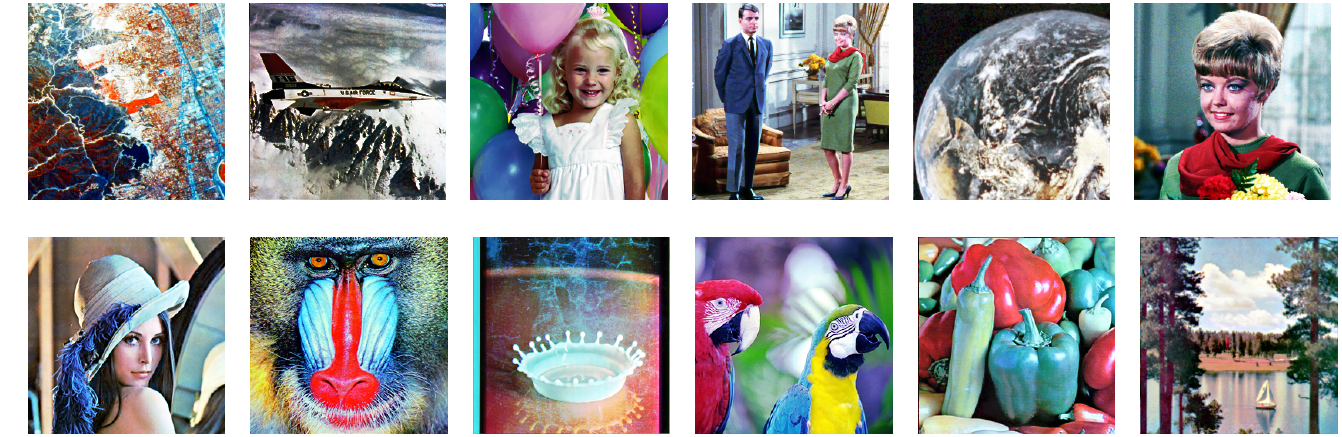
Figure 21. Results of separable histogram equalization with Nikolova and Steidl’s exact histogram equalization algorithm.